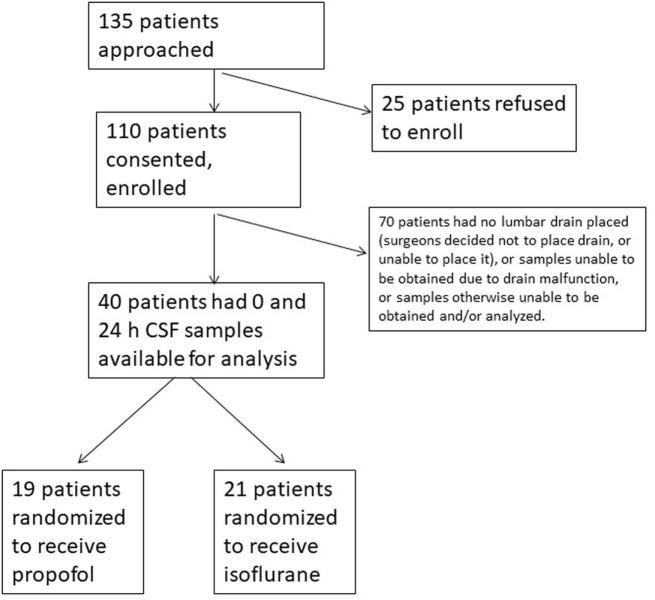
CONSORT diagram/flow chart of the study population. CSF, cerebrospinal fluid.